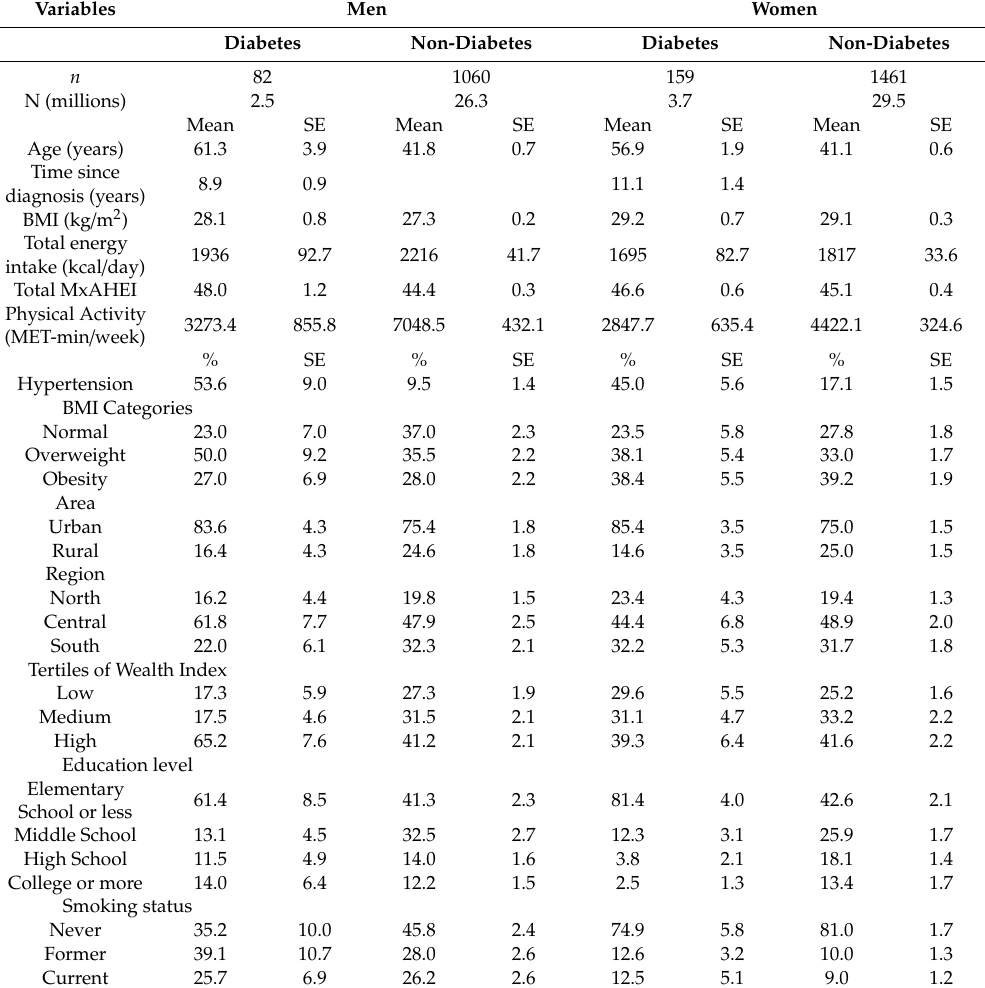
Table 2. Sex-stratified characteristics of Mexican adults by diabetes status ( n = 2762) a .